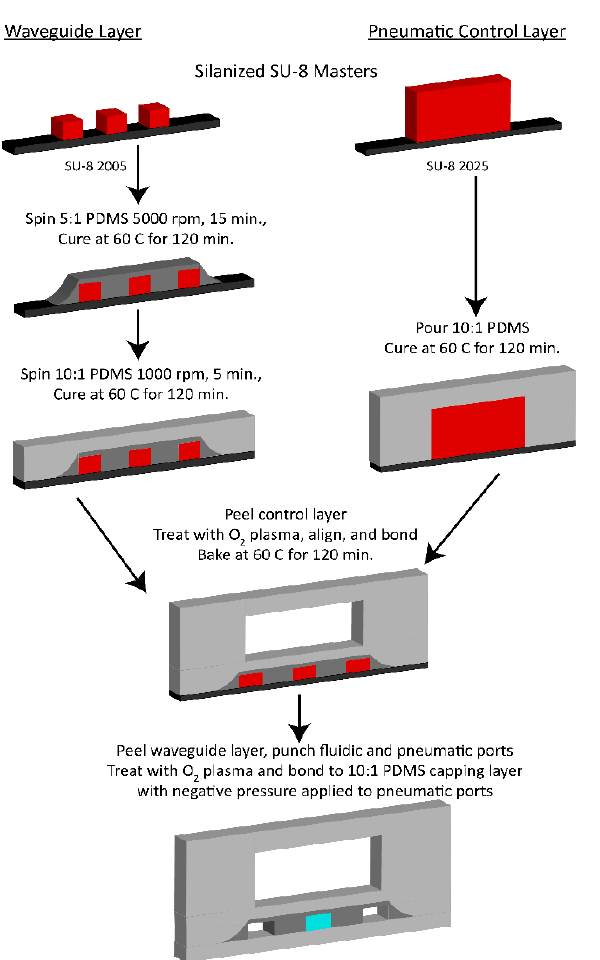
Figure 3. Fabrication of PDMS devices. A fabrication workflow is illustrated with 5:1 PDMS in dark gray, 10:1 PDMS in light gray, SU-8 in red, and silicon in black.